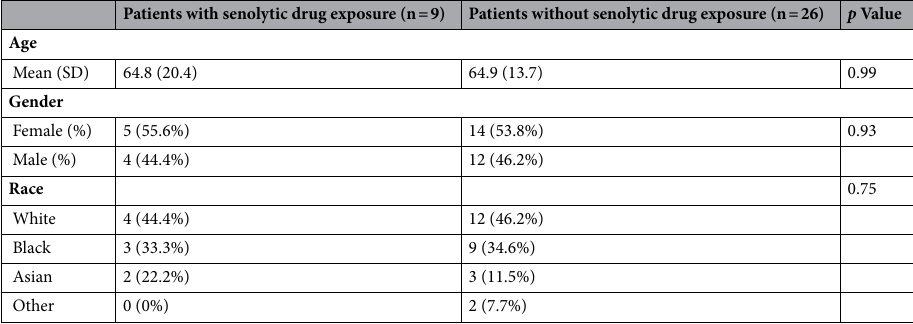
Table 1. Demographics and clinical characteristics of patients with glaucoma, glaucoma suspect, or ocular hypertension and history of senolytic drug exposure and matched patients without senolytic drug